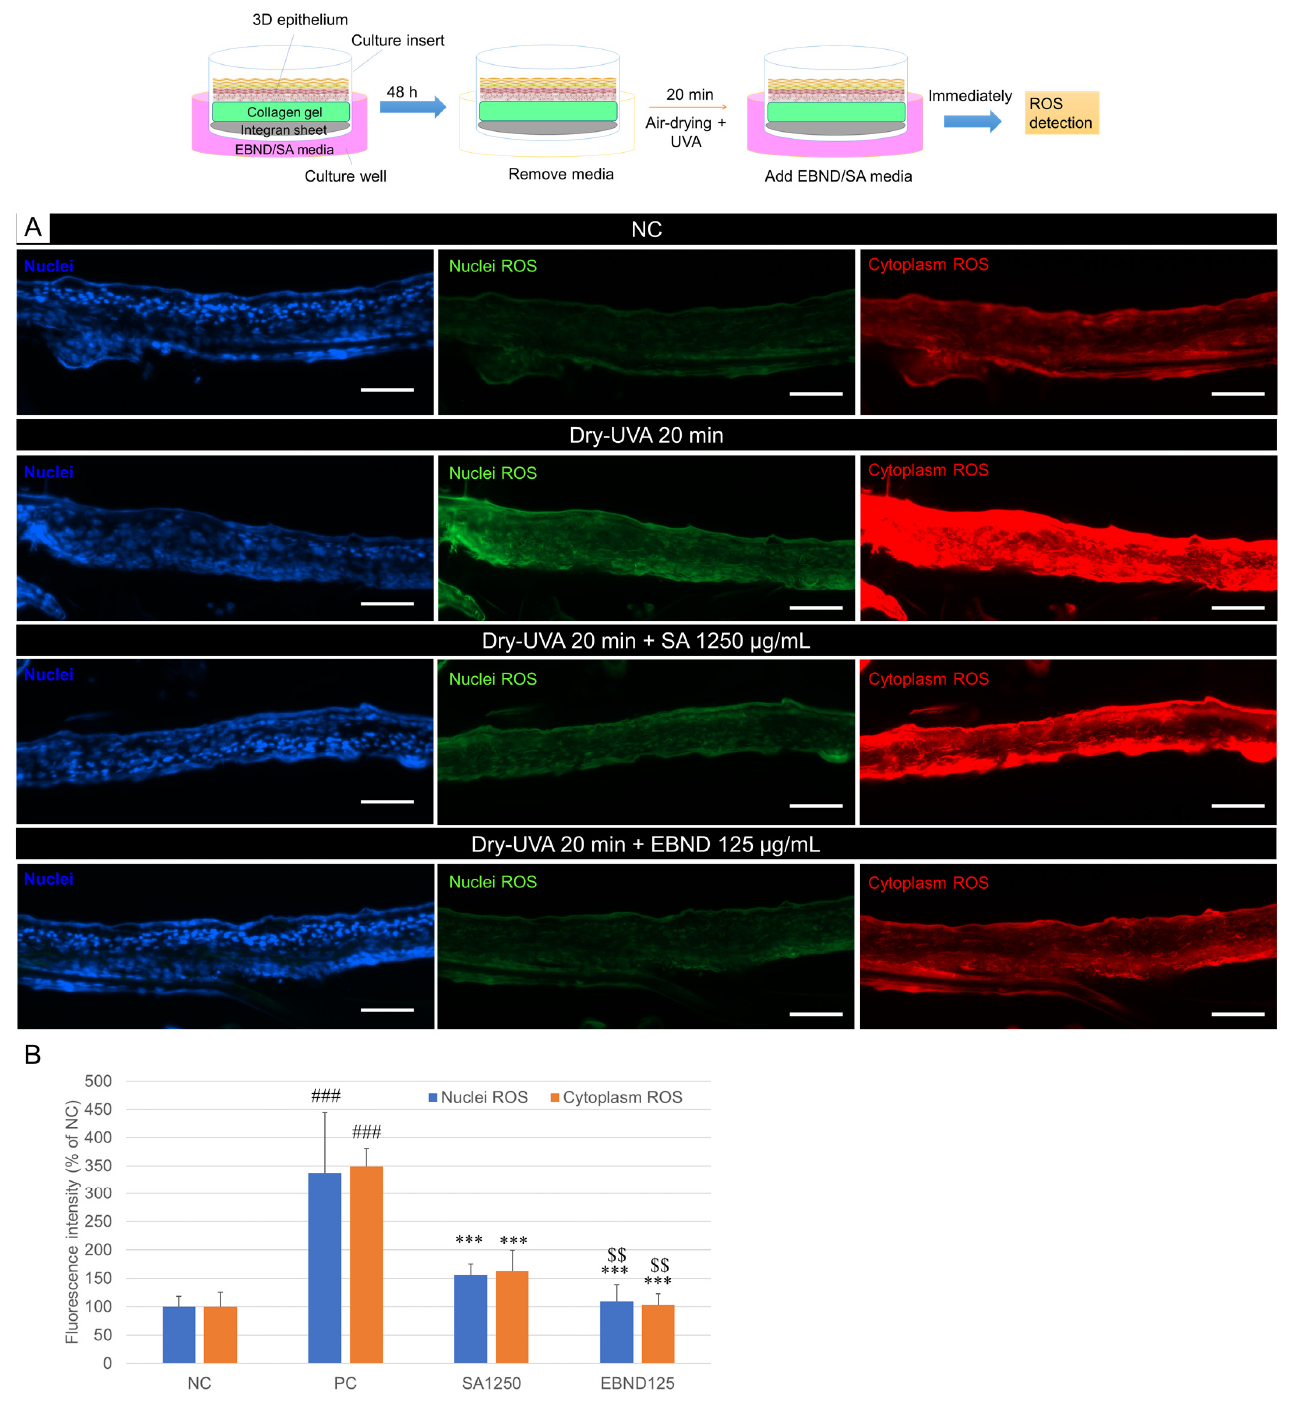
Figure 7. Effects of EBND and SA on Dry-UVA- induced ROS in 3D epithelium equivalents. The top illustration represents the experimental procedures. ( A ) Typical images of CellROX ® orange and green staining. Blue: Hoechst 33342; Green: nuclei ROS; Red: cytoplasm ROS. Scale bar = 200 μ m ( B ) Quantitative analysis of cellular ROS. Intensity of green and red fluorescence was analyzed with Image J software. ### p < 0.001 vs. NC; *** p < 0.001 vs. PC; $$, p < 0.01, vs. SA1250. Each bar represents the mean ± SD of the three independent experiments.